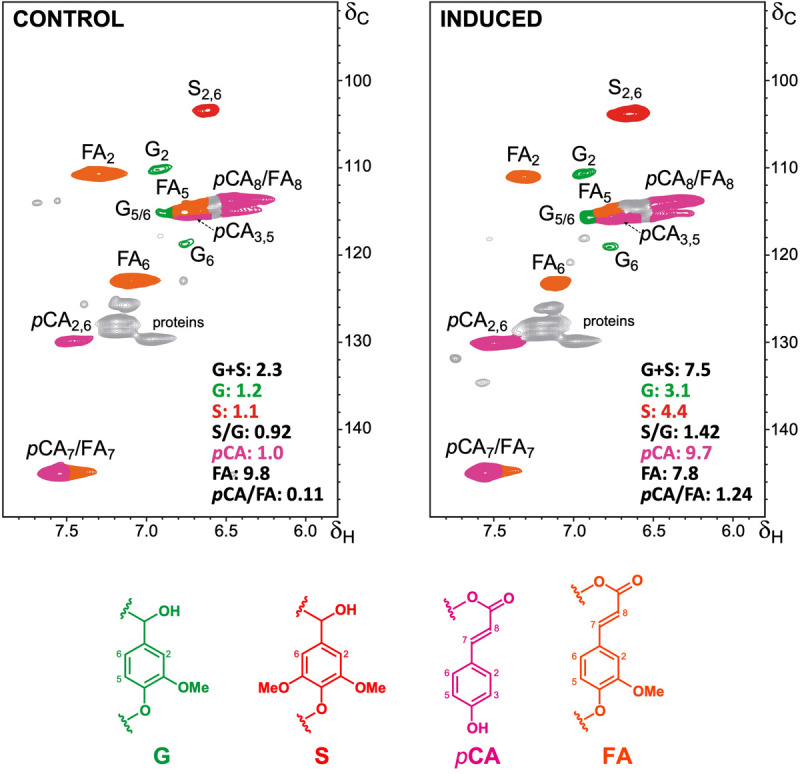
Structural characterization of lignin by NMR. 2D-HSQC-NMR spectra (in DMSO-d6) is shown for the aromatic/unsaturated regions (δC/δH 90–150/5.8–8.0) of whole cell walls from control and induced sugarcane cells. Main structures found are: G, guaiacyl lignin units; S, syringyl lignin units; pCA, p-coumarates; FA, ferulates. The structures are colored to match the assigned contours in the NMR spectra. Integrated values for each monomeric G, S, pCA and FA units (as per total lignin and carbohydrate units) and the corresponding S/G and pCA/FA ratios are provided.